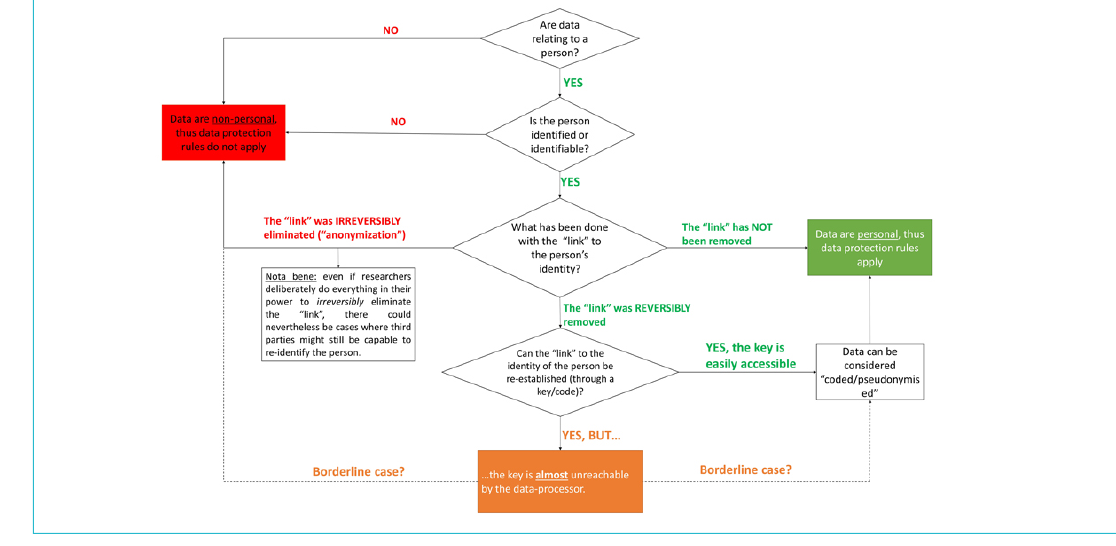
Figure 1: Ascertaining whether the data in a research-project are personal or not. A supportive decision-tree. This decision-tree has merely in- dicative and instructive (rather than prescriptive) purposes, since every schematisation involves some degree of simplification and approxima- tion. Specificities of each single case (such as linking possibilities) might lead to different